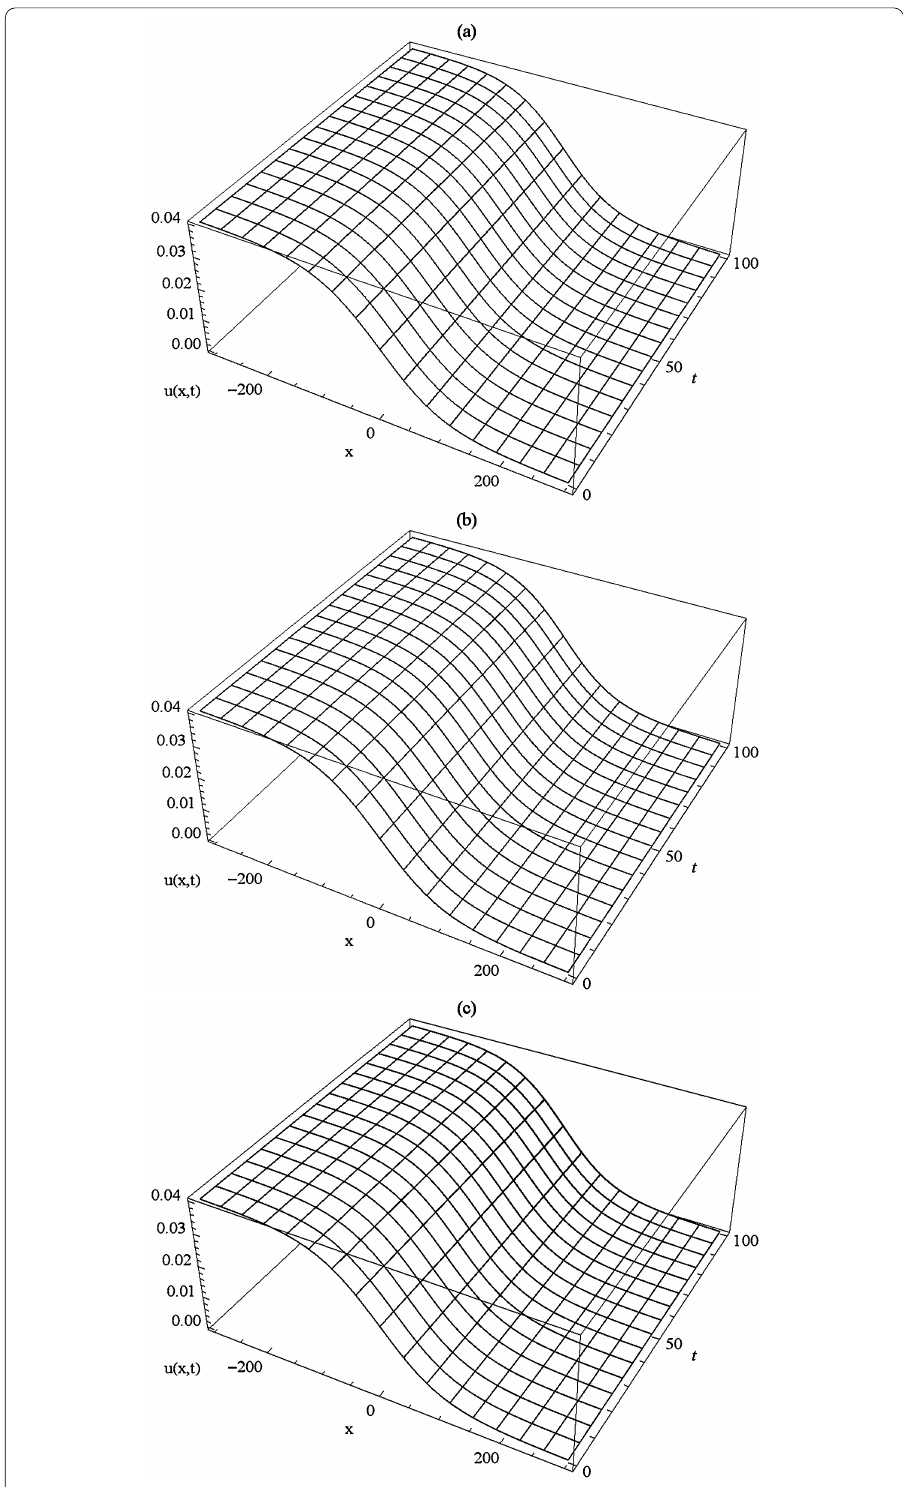
Figure 1 Combining the surface exact solution (2) and the surface approximation (16) for α = 0.7, a = 1, b = 0.01, and c = 1. (a) The surface of the exact solution. (b) The surface of the second approximation. (c) Combining (a) - (b)